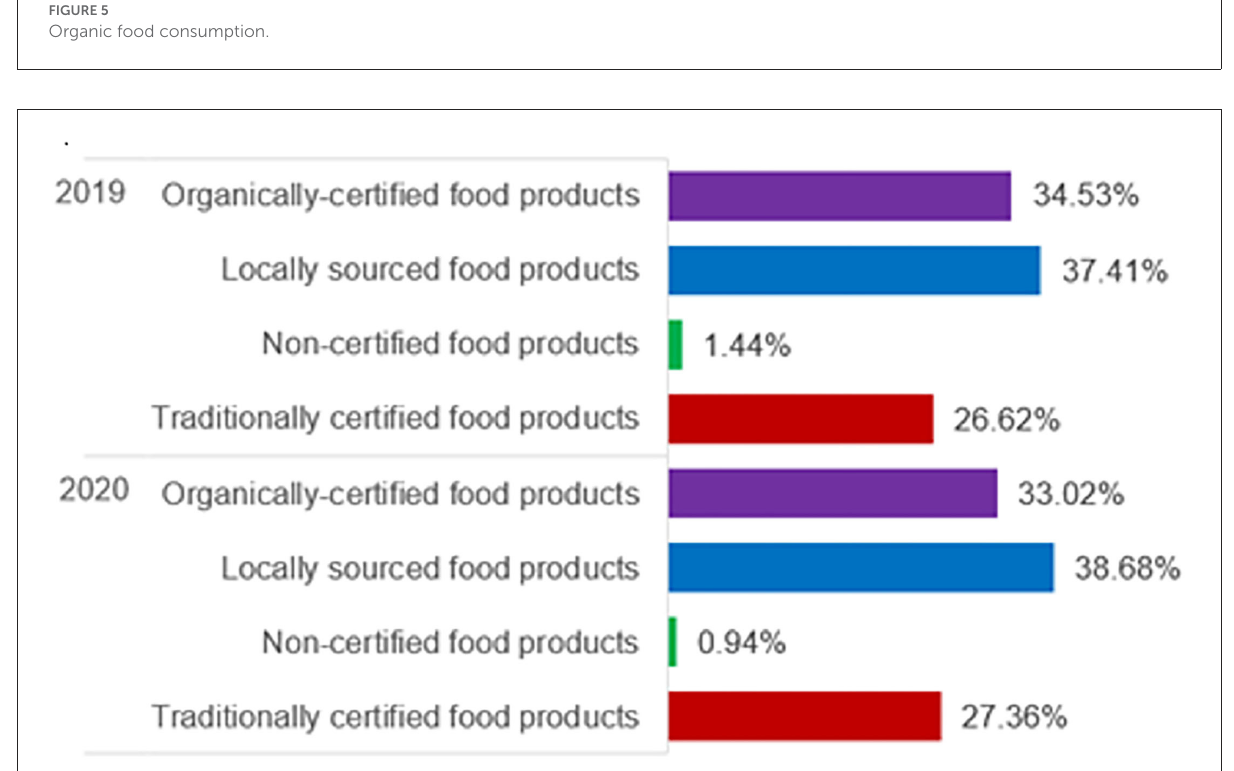
FIGURE6 Preferences for different types of food products when (hypothetically) the price is equal.